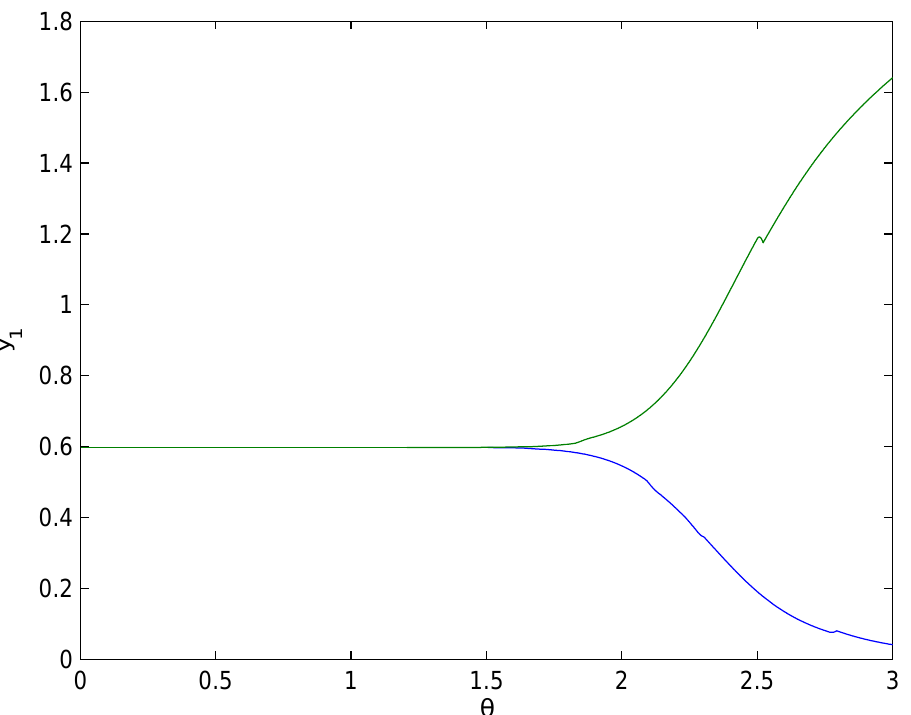
Figure 3. Bifurcation figure of model (62): the relation of t and y 1 . The bifurcation value is approxi- mately equal to 1.7.